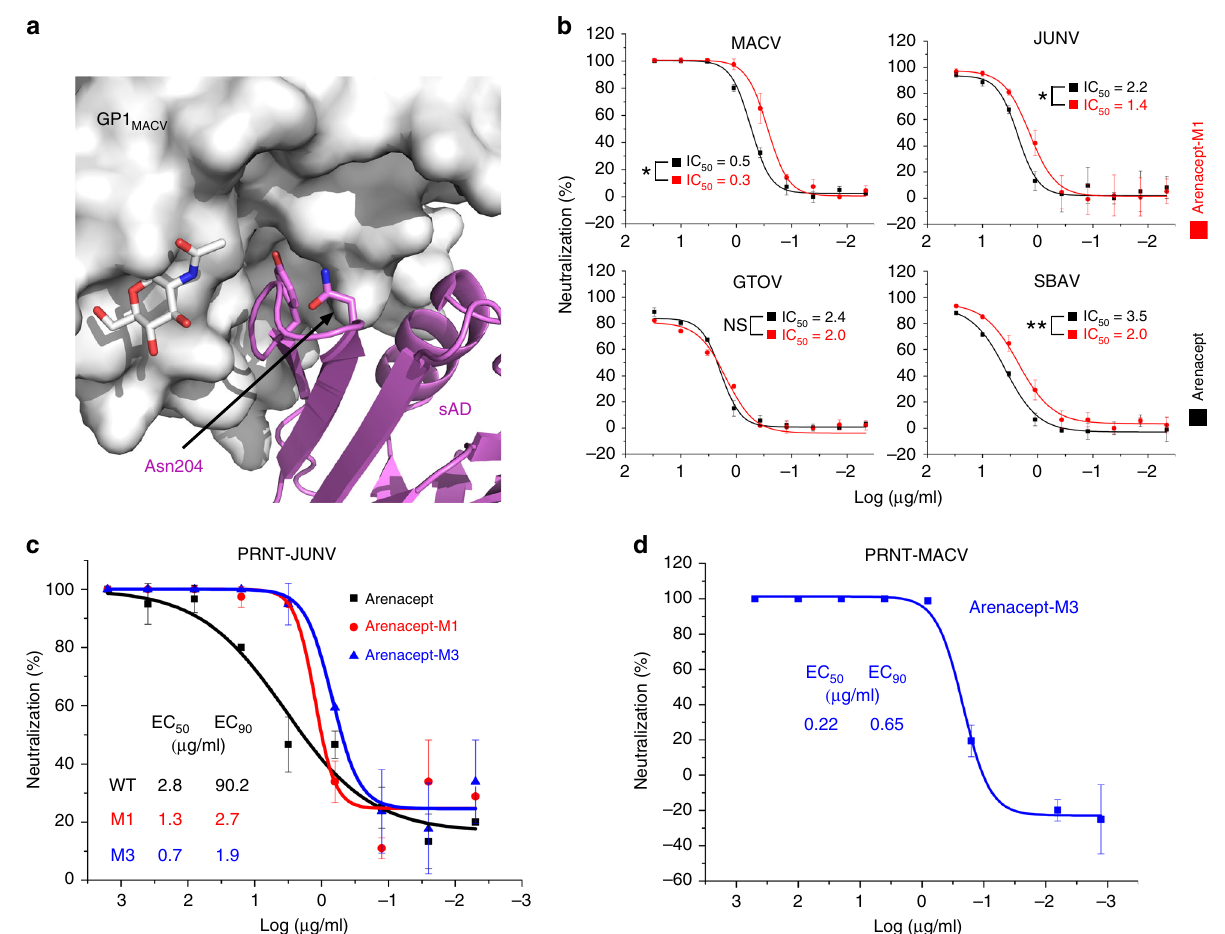
Fig. 5 Augmenting Arenacept via rational design. a A glycan attached to Asn204 of sAD would prevent binding to GP1. The sAD/GP1 MACV complex is shown in a gray surface and in magenta ribbon for GP1 MACV and sAD, respectively. Asn204 of sAD, which is in proximity to the GP1 surface, is indicated. b Neutralization of the indicated pseudotyped viruses with Arenacept (black curves) and Arenacept-M1 (N204A, red curves), representative curves are shown. Differences in IC 50 values (averages of n = 3, n = 5, n = 3, and n = 3 independent repeats for MACV, JUNV, SBAV, and GTOV, respectively) that are statistically signi fi cant (two-tailed Student ’ s t test) are indicated with * p < 0.05 or ** p < 0.005. Error bars represent standard deviations of technical repeats c Plaque reduction neutralization test using live Espindola strain JUNV and Arenacept (WT, black curve), Arenacept-M1 (M1, red curve), and Arenacept-M3 (M3: N204A + E430G, blue curve) in the presence of complement. For each variant, the EC 50 and EC 90 values are indicated. Error bars represent standard deviations. For this experiment, we used two technical repeats. d Plaque reduction neutralization test using live Carvallo strain MACV and Arenacept-M3 in the presence of complement. The EC 50 and EC 90 values are indicated. The neutralization curve was generated by aggregating data from three technical repeats. Error bars represent standard deviations. For all relevant panels, source data are provided as a source data